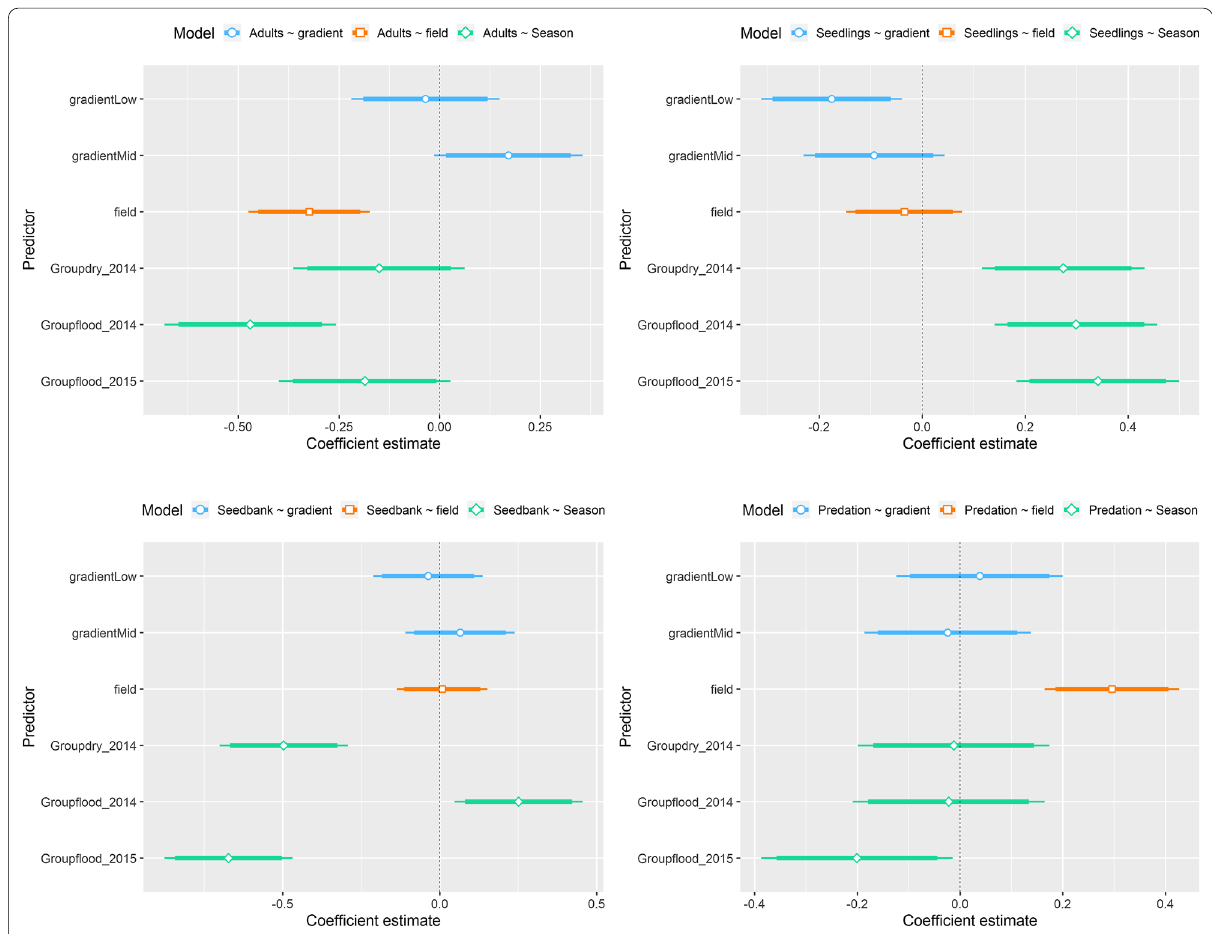
Fig. 6 Standardized regression coefficients of different linear mixed-effects models (LMMs. with random and fixed effects) to test the main effects of seasonal flood disturbance, type of grasslands, and topographical conditions on growth stages of population (adults and seedling) and population-related ecological processes (seed bank and predation), Pantanal wetland. The associated 95% confidence intervals and the relative importance of each factor expressed as the percentage of explained variance are